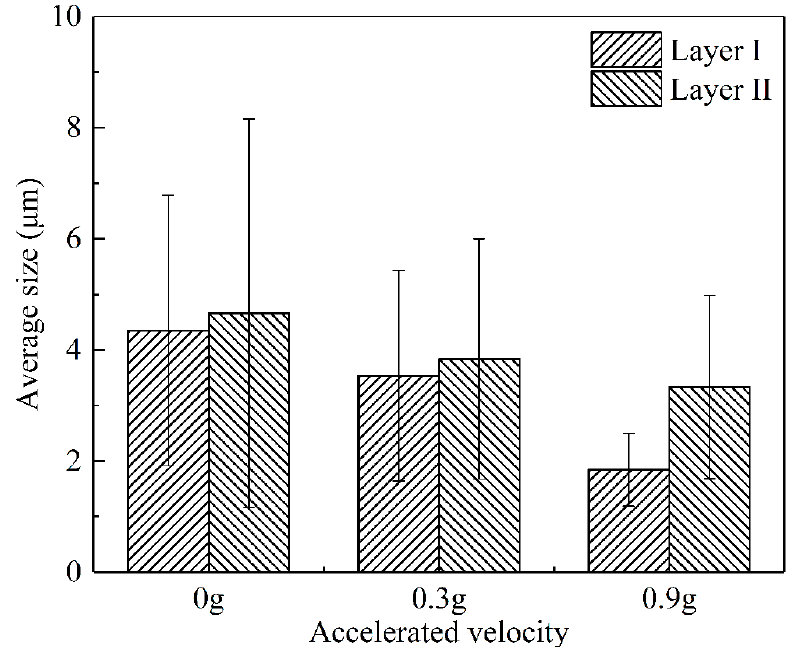
Figure 7. The sizes of the Mg 2 Si phase in the IMCs layers of the Mg–Al interfaces.